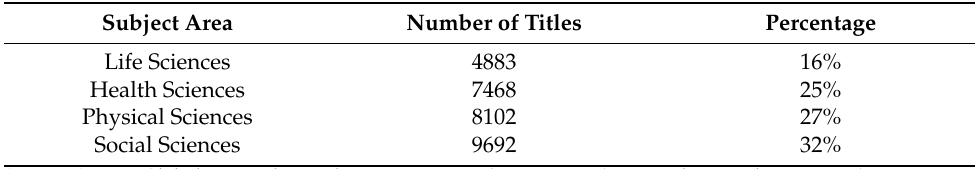
Table 1. Scopus content coverage by subject